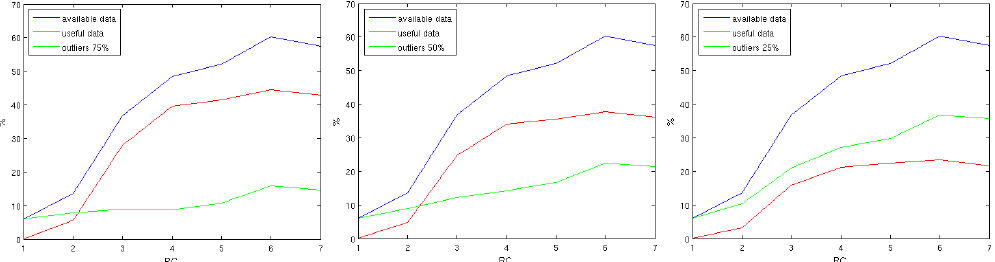
Figure 11. Percentage of available data (blue), outliers (green) and resulting useful data (red) for each range cell. ( a ) Applying 25% outliers. ( b ) Applying 50% outliers. ( c ) Applying 75%